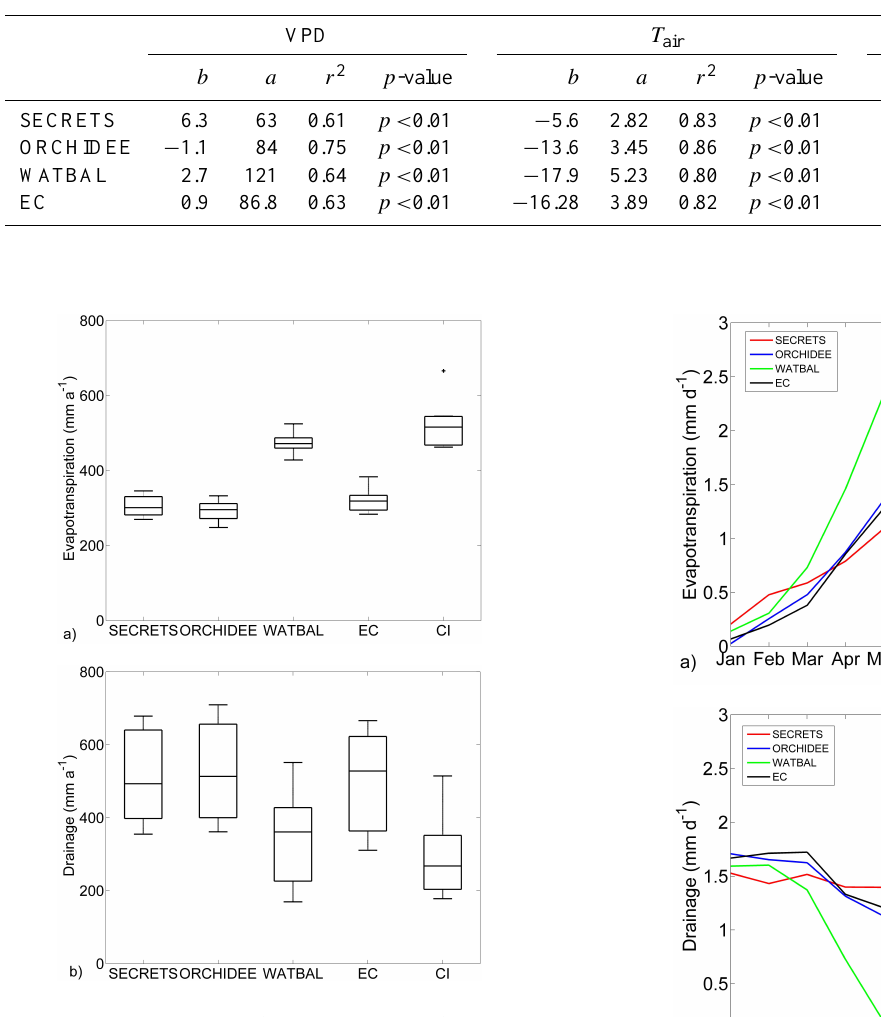
Fig. 5. Box and whisker plots of annual estimates of evapotranspi- ration (a) and drainage (b) for the five different approaches used in this study. Data represent the period 1997 through 2008 with- out 1998, 1999 and 2003. Box lines depict the lower (25%) quar- tile, median, and upper (75%) quartile values for each variable. Whiskers, on either end of the box, designate the 95 percentile for each variable. Outliers are represented by the “plus” symbol beyond the ends of the whiskers.